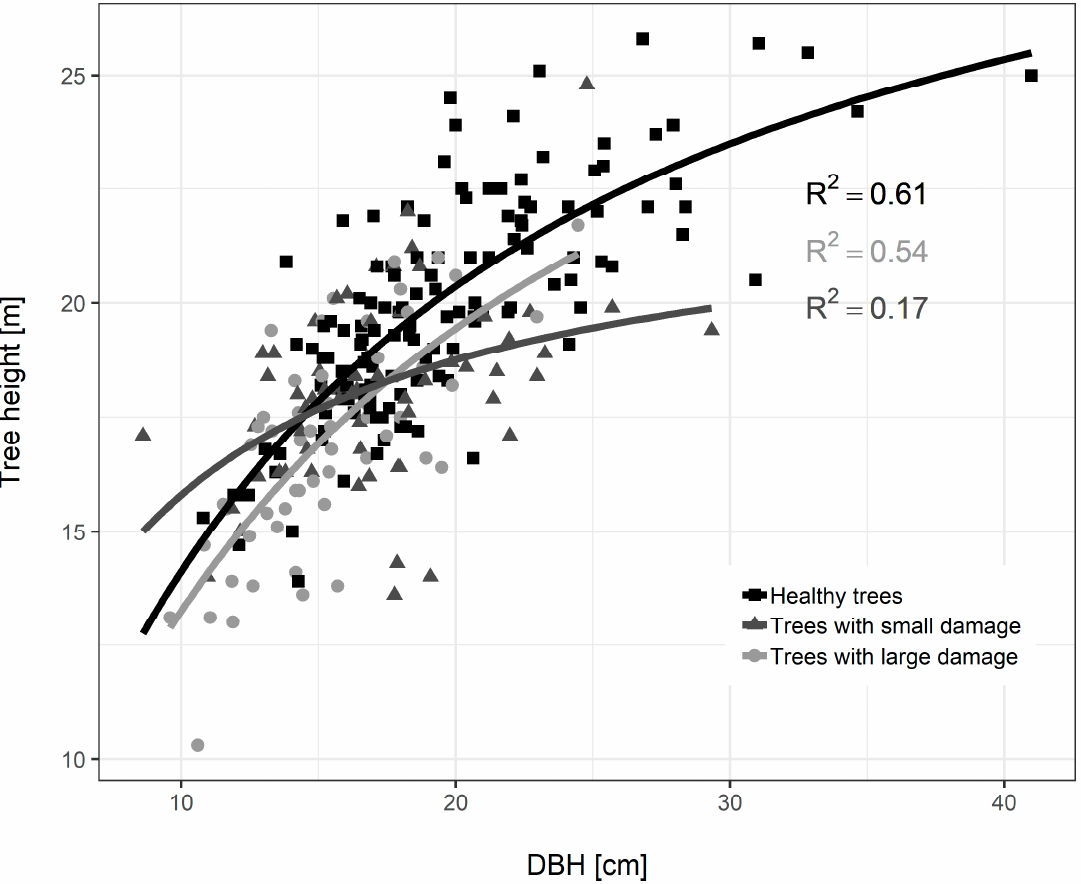
Figure 2. The relationship between diameter at breast height (DBH) and tree height of healthy spruce trees (parameter a = 1.00, and b = 0.18), trees with small damage (parameter a = 0.46, and b = 0.22), and trees with high game damage (parameter a = 1.09, and b = 0.18).